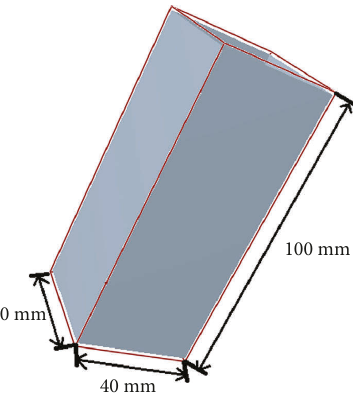
Figure 1: Geometric